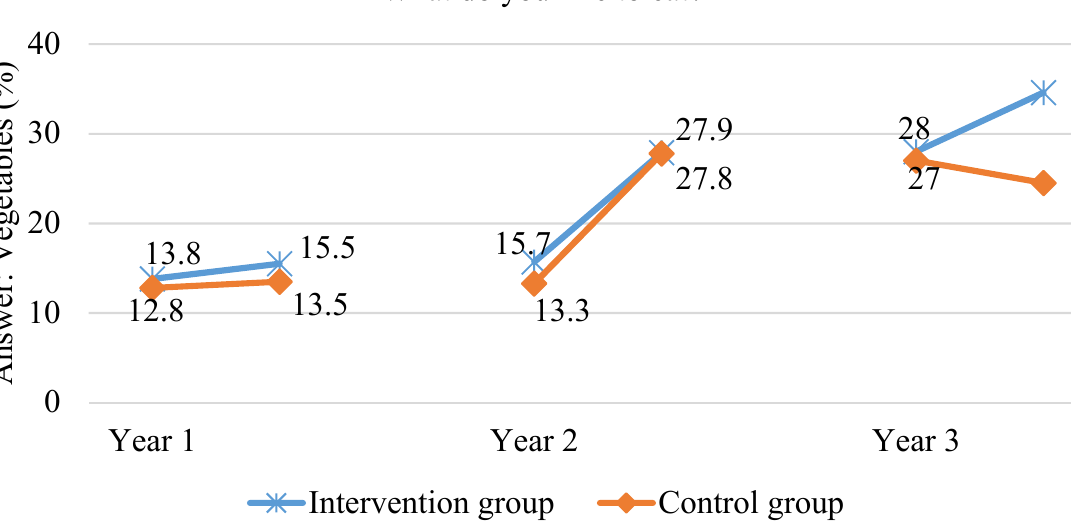
Figure 8. The proportion of children indicating vegetables as products they like to eat during the three years of the study.